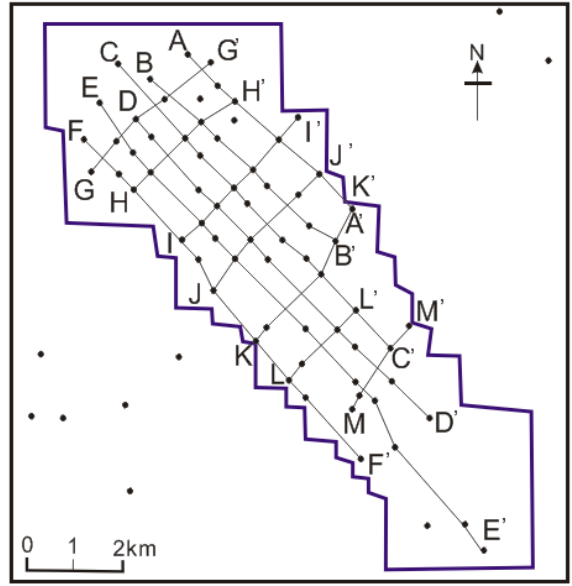
Figure 3. Locations of measured cores and stratigraphic cross-sections (region C in Figure 1).